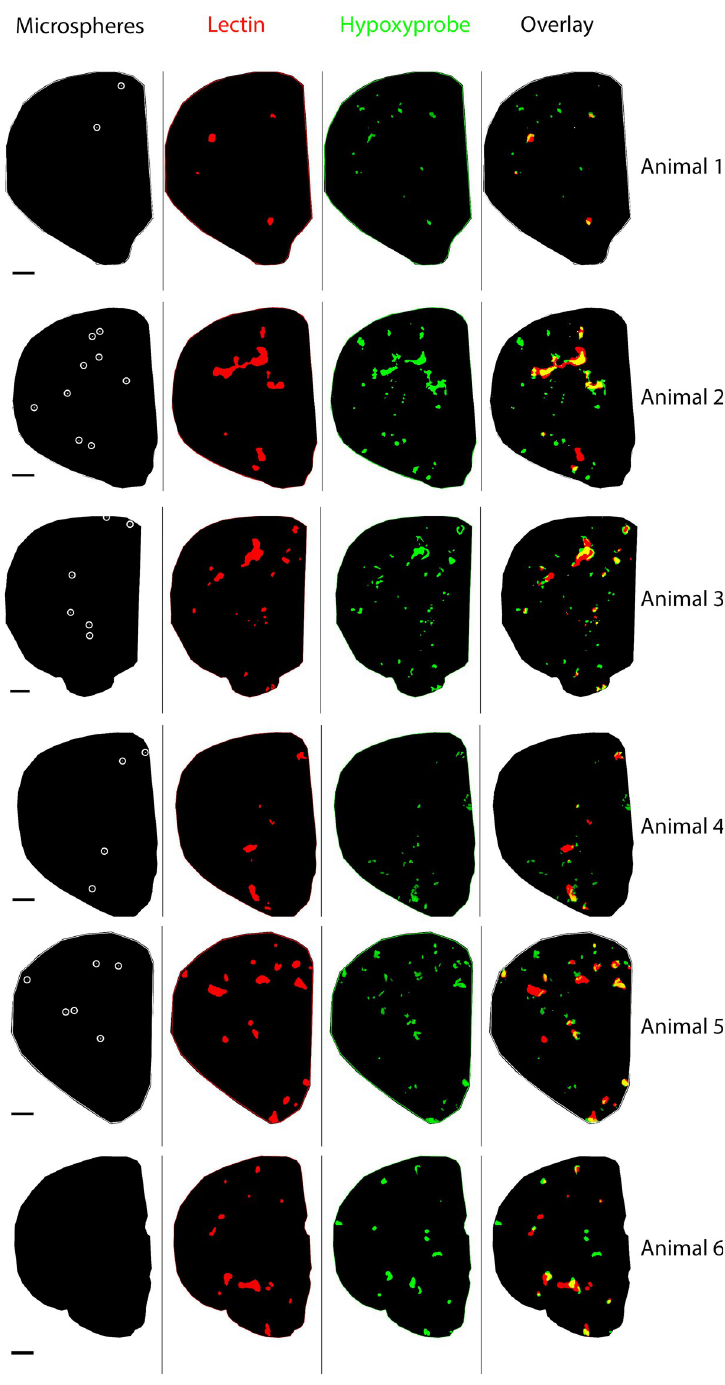
Fig 4. Per animal a representative segmented brain section of the intervention hemisphere. From left to right: microspheres (centre of white circles), ischaemia (red), hypoxia (green) and overlay of the three channels. In yellow is shown the overlap between ischaemia and hypoxia. Scale bar 1000 μ